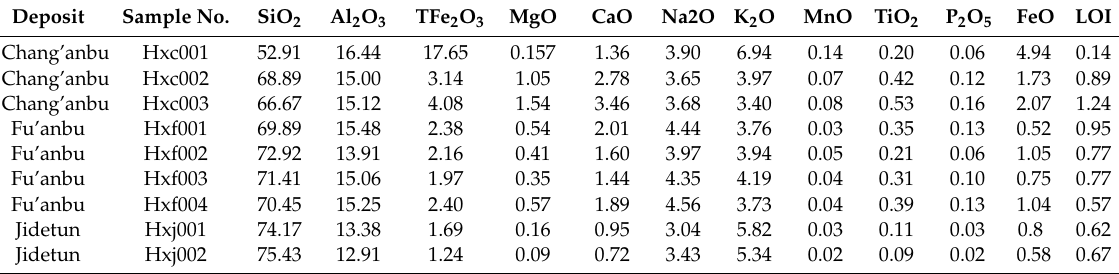
Table 4. Major element data for ore-hosting rocks from the Chang’anbu, Fu’anbu, and Jidetun ore deposits